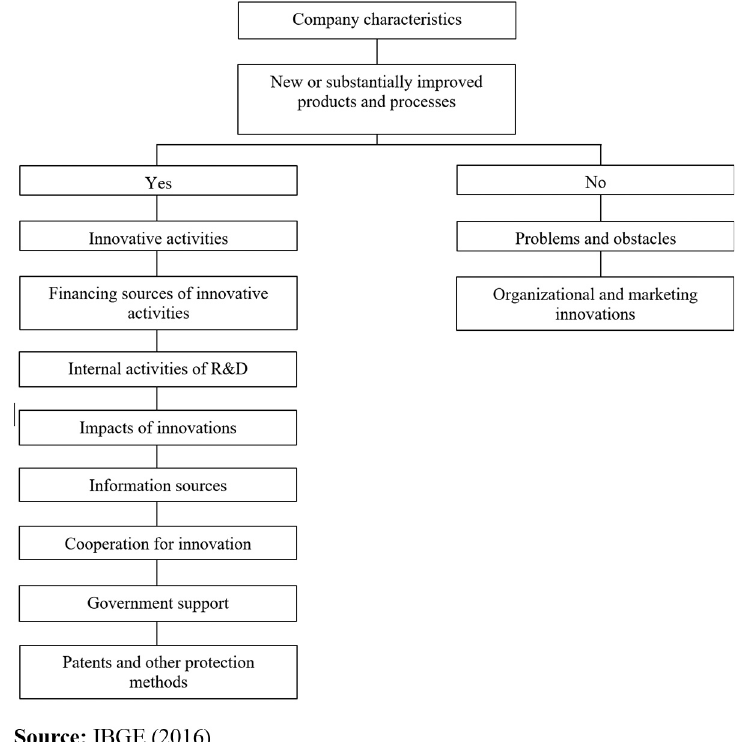
Figure 1. Measurement structure of innovation indicators of the PINTEC